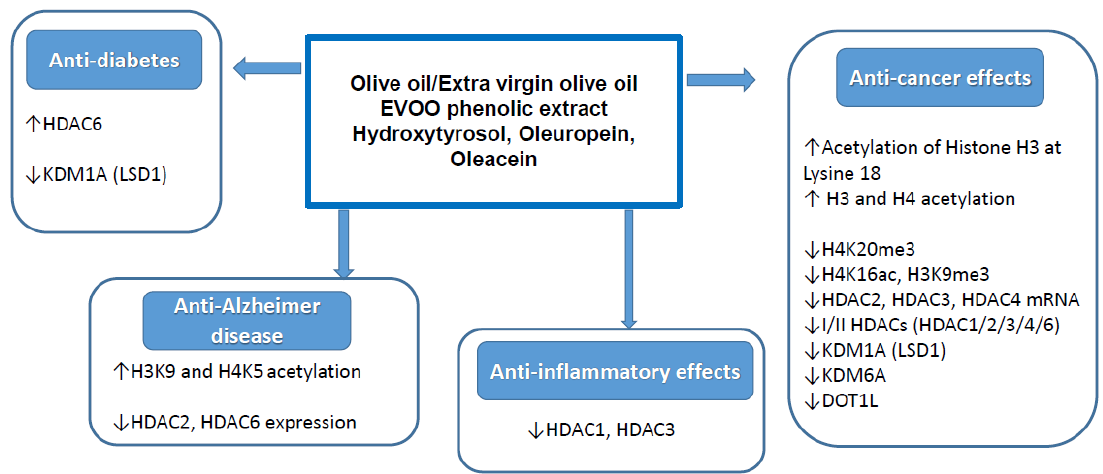
Figure 4. Main effects of olive oil and/or its phenolic compounds on histone modification in relation to different biological and healthy properties. “ ↑ ” and “ ↓ ” indicate increment and decrement of histone modification, respectively.